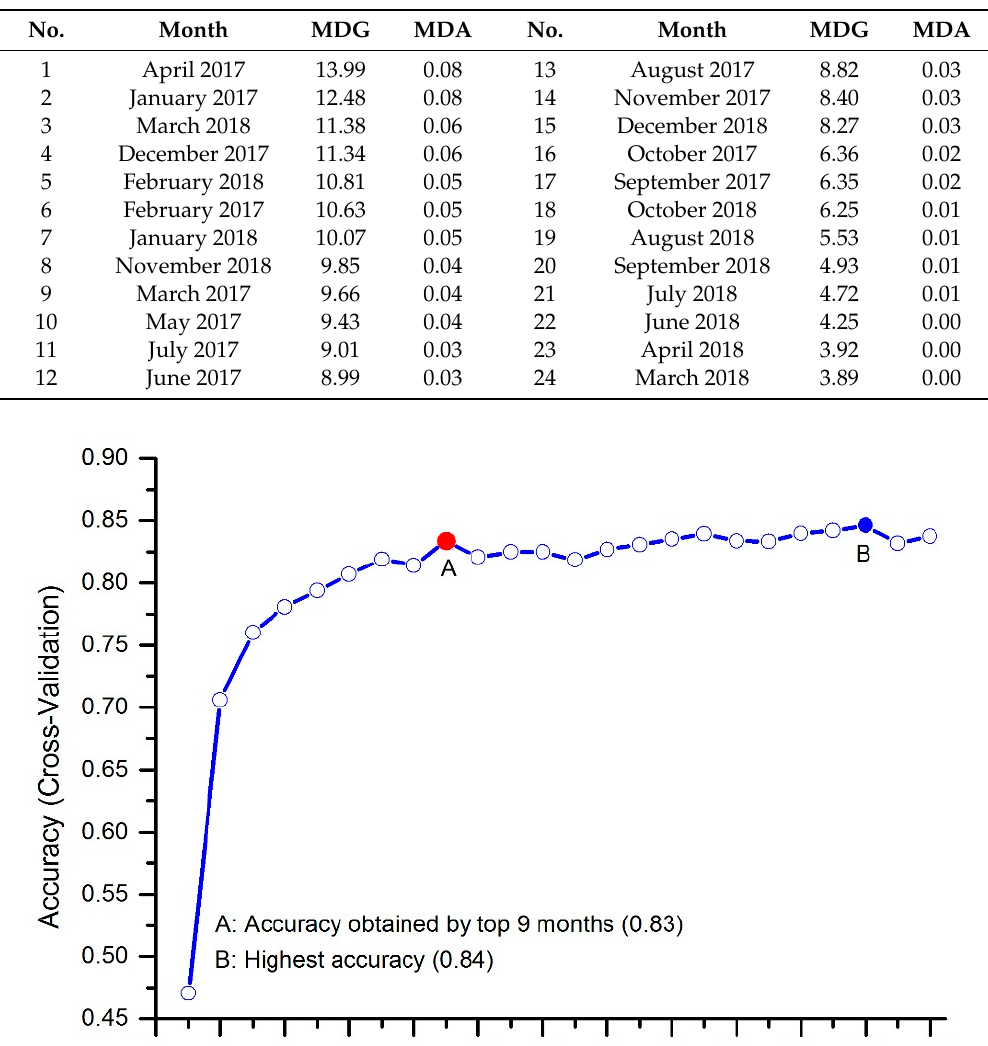
Table 2. Variable importance contribution of different months in terms of the MeanDecreaseGini (MDG) index and mean decrease in accuracy (MDA), ranging by importance.